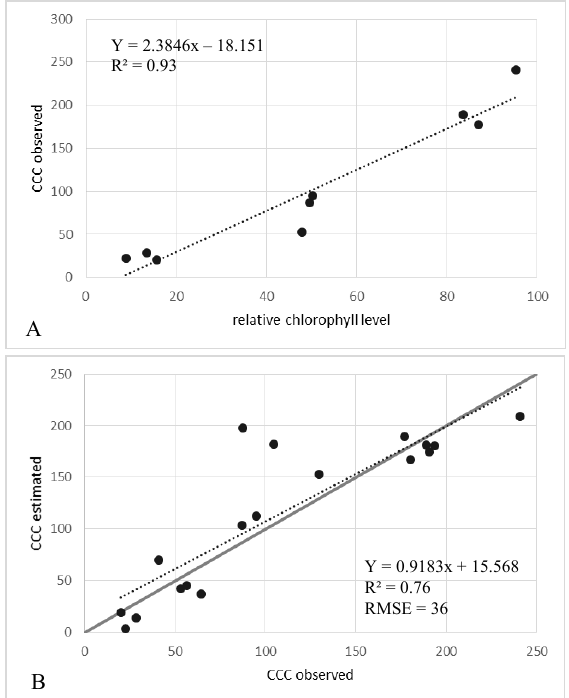
Figure 4. A: Calibration model for the June data set to turn relative chlorophyll level values into CCC SPAD . B: Estimated CCC est plotted vs. the corresponding observed CCC SPAD measurements on June 27 th 2011. The solid diagonal line represents the 1:1